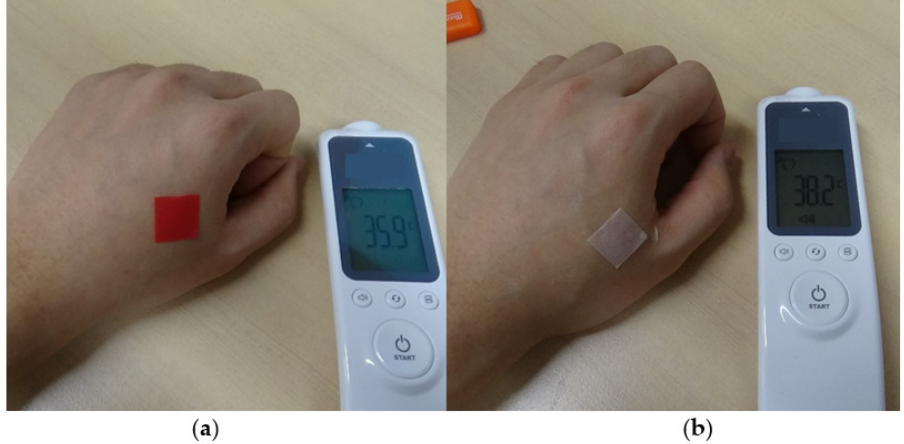
Figure 15. Patch attached to the skin on the back of the hand with different temperatures: ( a ) normal temperature condition and ( b ) fever condition.